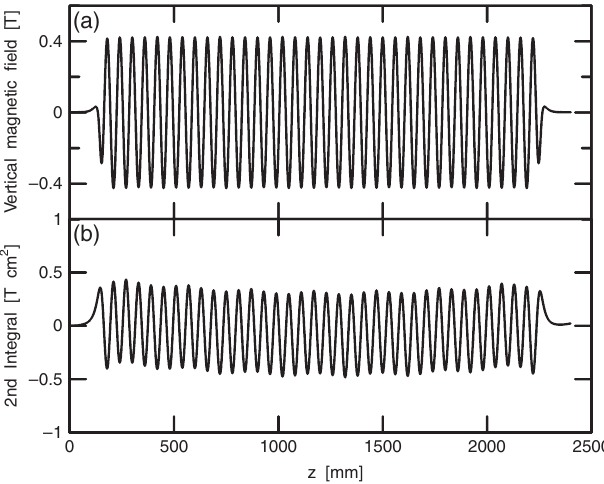
FIG. 6. Vertical magnetic field distribution and its second integral of a 35 period pseudowiggler consisting of seven sets of the measured magnetic field distribution for the model wiggler at the gap of 30 mm: (a) the vertical magnetic field and (b) its second integral, which is proportional to the electron trajectory.